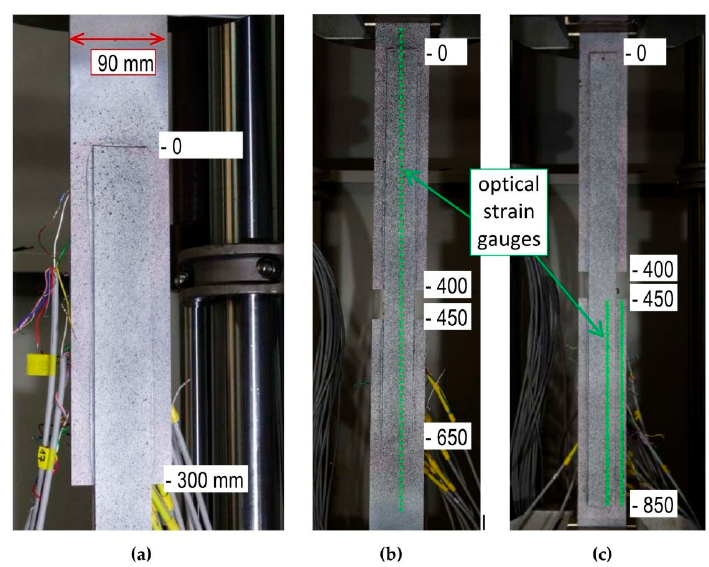
Figure 4. ( a ) Specimen prepared (painted) for optic measurement, ( b ) virtual measurement base used to calculate strain, and ( c ) base used to calculate displacement.